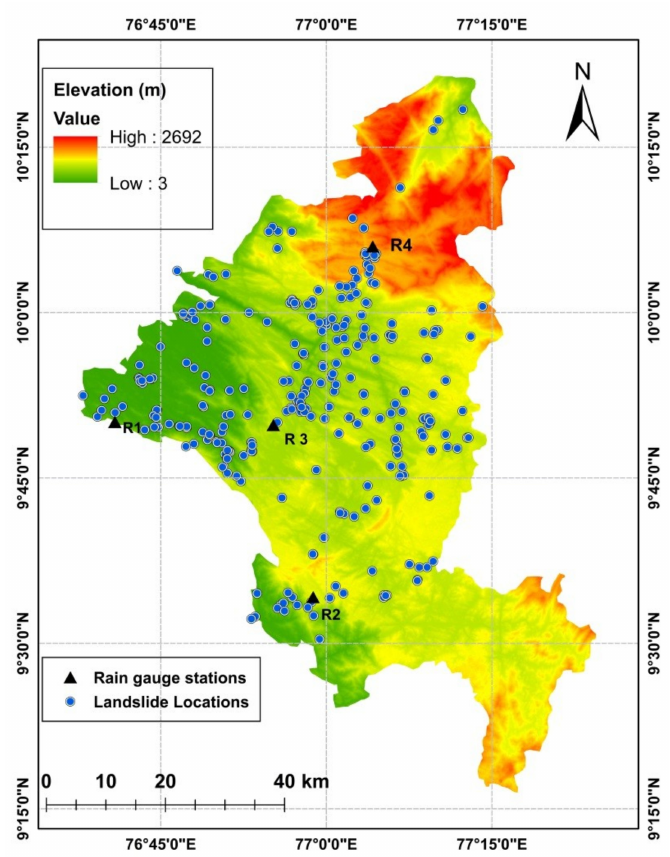
Figure 3. Digital Elevation Model [35] of the Idukki district along with the spatial distribution of landslide locations and rain gauge stations (2010–2018).